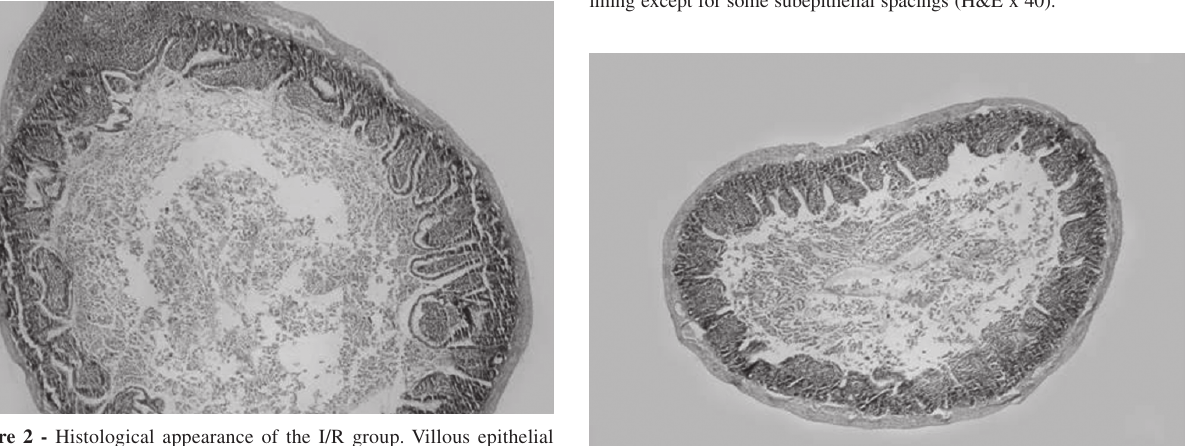
Figure 3 - Histological appearance of the SNP group. A contact epithelial lining except for some subepithelial spacings (H&E x 40).